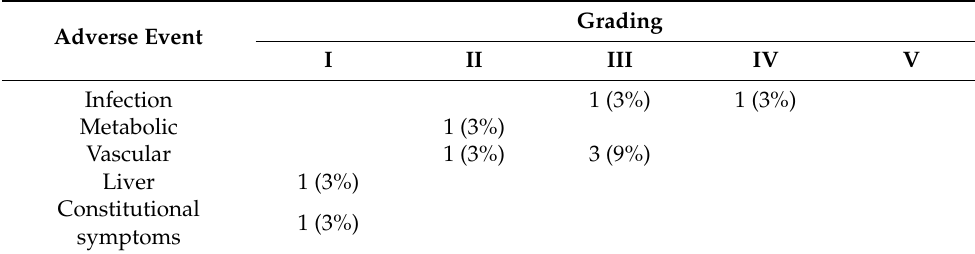
Table 3. Adverse events are probably related to the study